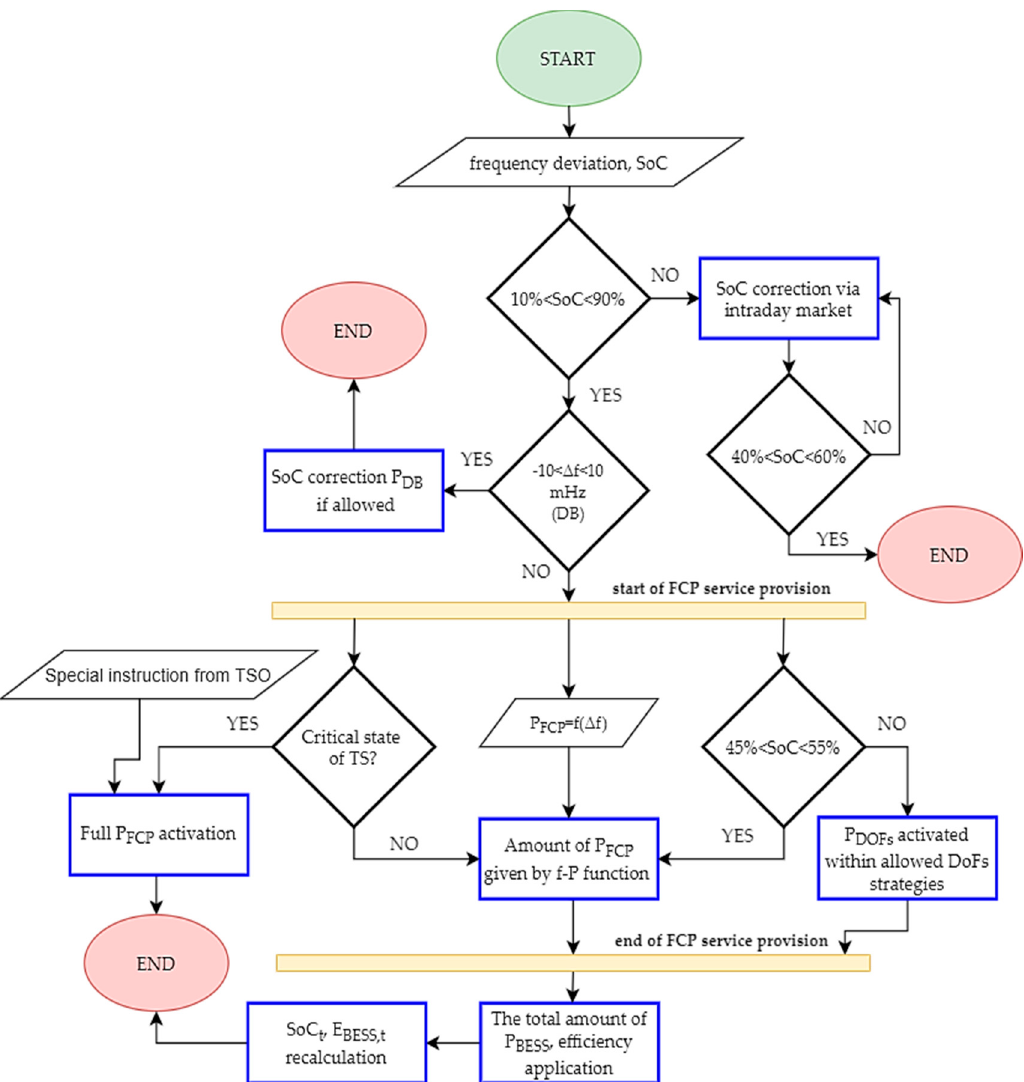
Figure 9. Flow chart representing the proposed MATLAB code of the annual BESS operation model. P FCP : Power provided within the FCP service given by equation (2), E BESS,t : Total energy flow through the BESS within year t calculated by equation (19), TSO: Transmission System Operator.